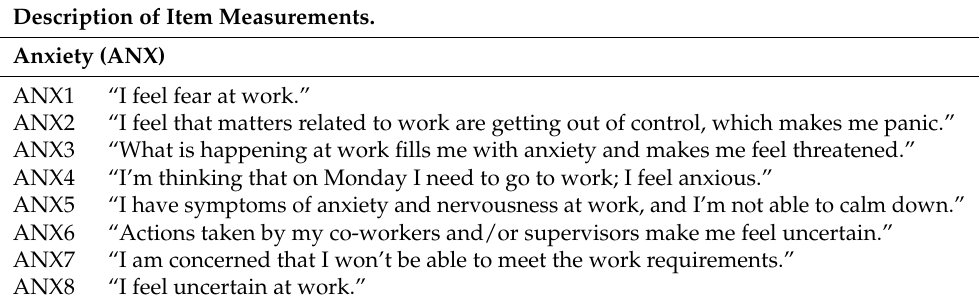
Table 1. Item measurements and their accompanying model constructions [13]. Description of Item